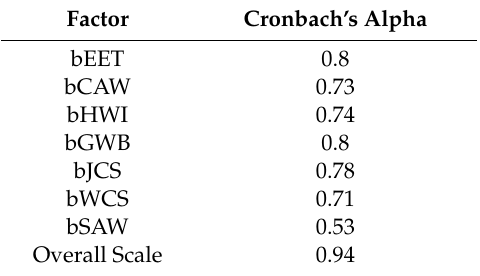
Table 4. Internal consistency of the brief